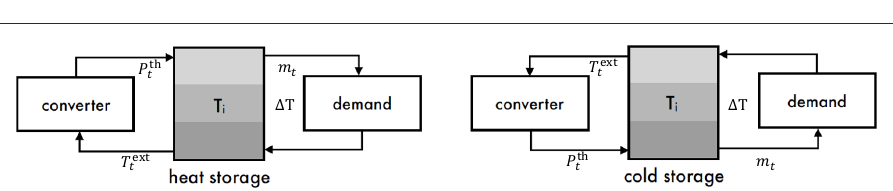
Figure 2 Connection between energy converters, thermal storages/grids and demand. The demand mass (cid:13)ow ( _ m t ) is calculated with a constant (cid:1)T on the demand side